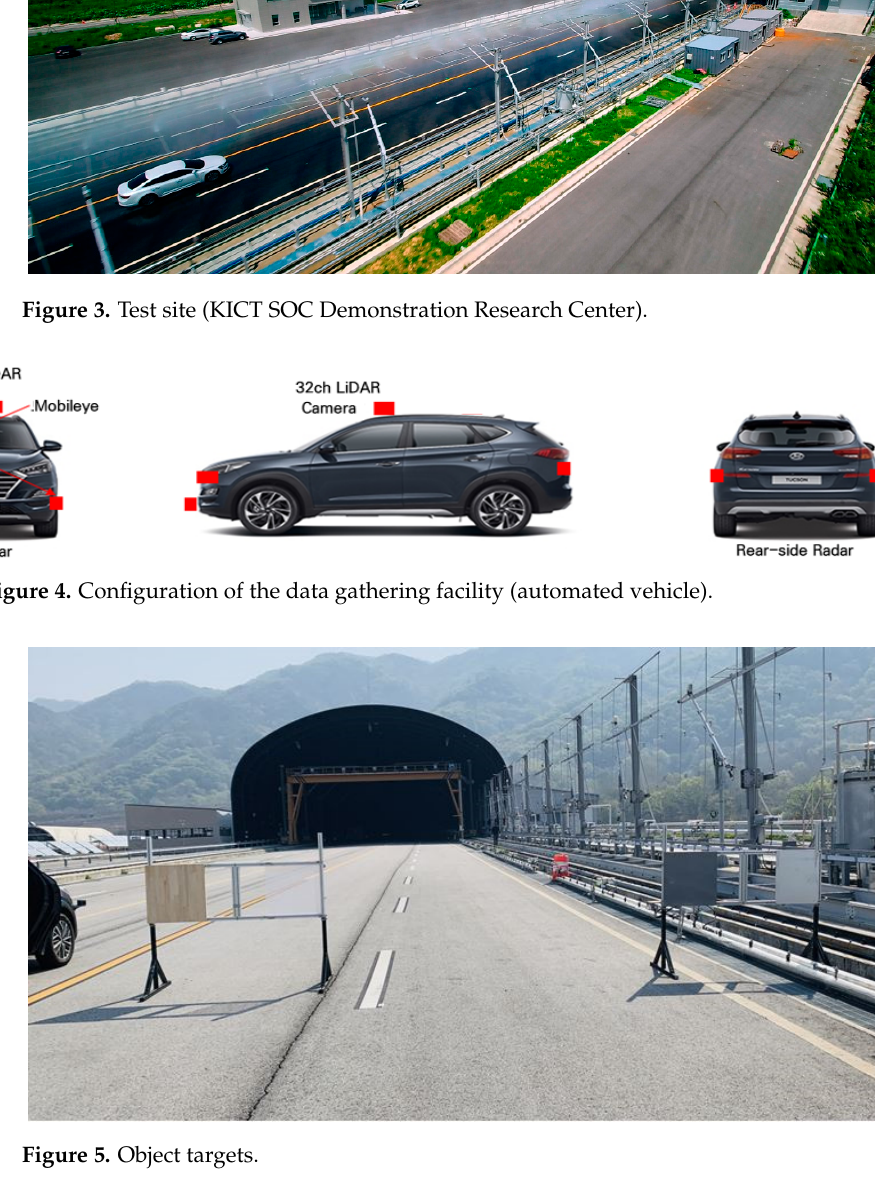
Figure 3. Test site (KICT SOC Demonstration Research Center).